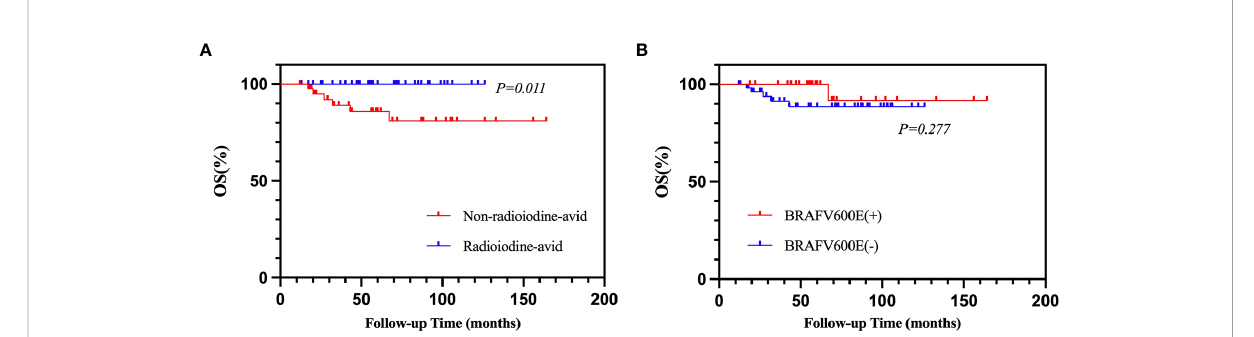
FIGURE 5 Kaplan – Meier analysis of OS in PTC patients according to radioiodine avidity status (A) and BRAF V600E mutation status (B) . OS, overall survival; PTC, papillary thyroid